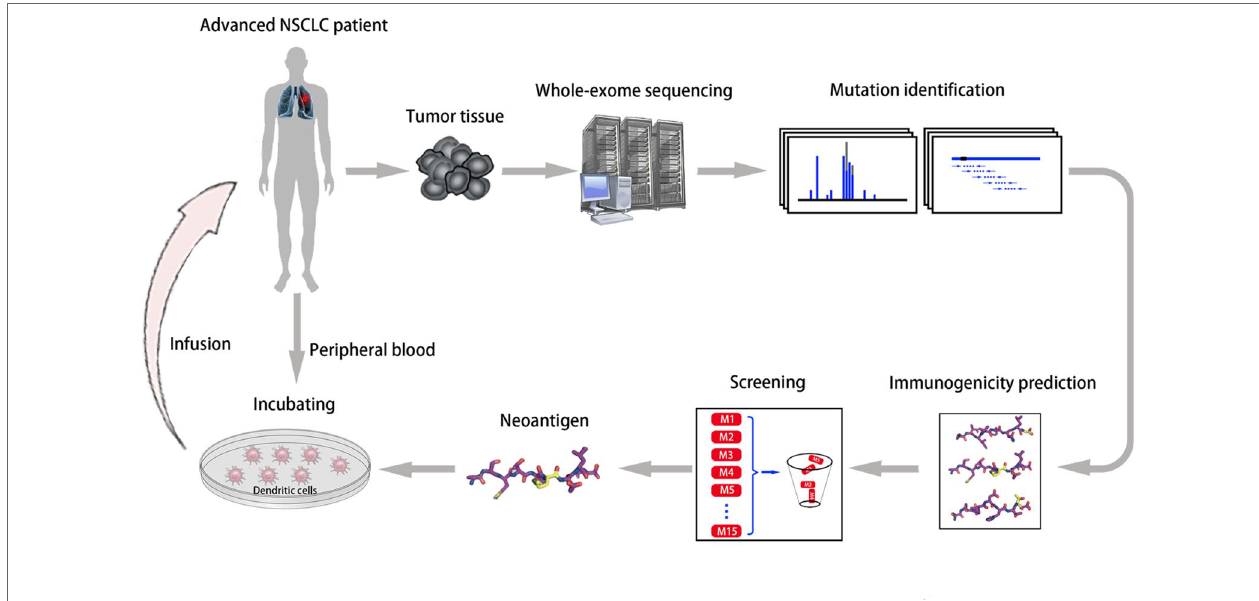
FIGURE 1 | Neoantigen-primed personalized DC vaccines for refractory NSCLC. We utilized whole-exome sequencing of tumor tissues, computational epitope prediction, and immunological approaches to screen for neoantigens from individual patients, and then infused autologous DCs pulsed with neoantigen-derived peptides into each patient (ClinicalTrials.gov Identifier: